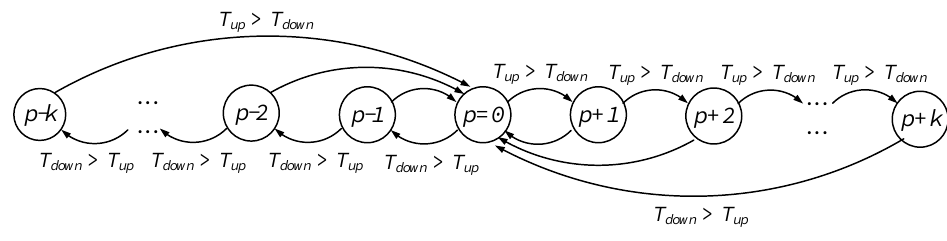
Figure 9. Request strength threshold: Threshold = Threshold − p ×